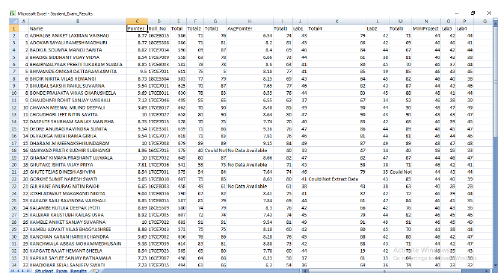
Figure 7. Output CSV File